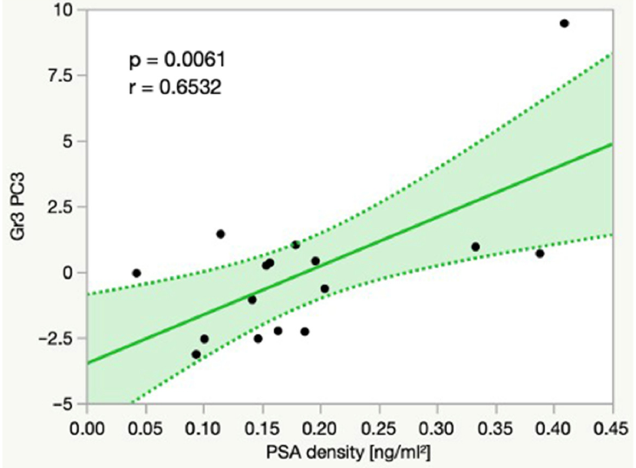
Figure 5. Linear correlation between the PSAd and a principal component called PC3 in Gr 3. Dotted line = confidence interval. Abbreviations: Gr = group, ml = milliliters, ng = nanogram, PC = principal component, PSAd = PSA density.